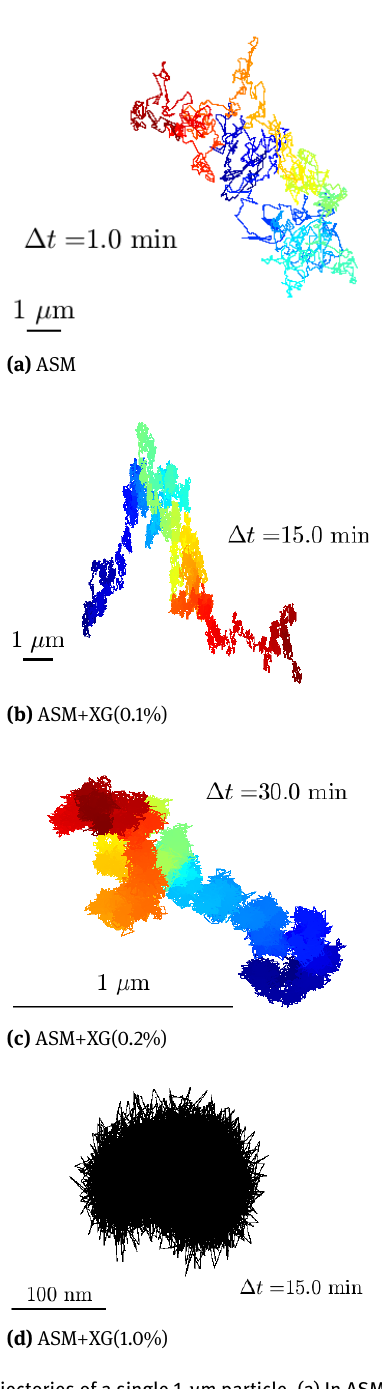
Figure 4: Trajectories of a single 1- µ m particle. (a) In ASM, the particle is diffusive, traveling over 10 µ m in 1.0min . (b) In ASM+XG(0.1%), the particle is subdiffusive at short times, but the particle is diffusive at long times, traveling over 10 µ m in 15.0min . (c) In ASM+XG(0.2%), again, the particle is subdiffusive at short times, and the particle is diffusve at long times, traveling over 1 µ m in 30.0min . (d) In ASM+XG(1.0%), the particle is no longer diffu- sive, as the particle only samples its local environment of ∼ 200nm in 15.0min .